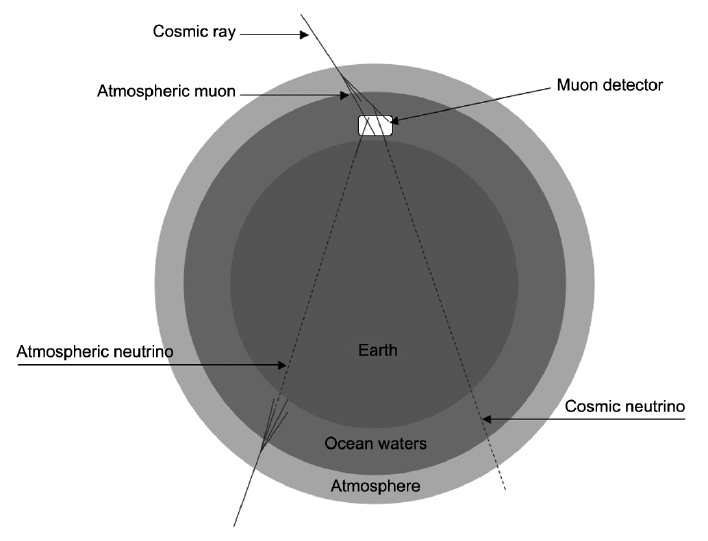
Fig. 2. Detection principle of an underwater neutrino telescope. This instrument will use the whole thickness of the Earth to shield the charged particles cosmic flux and therefore its field of view will be restricted to the hemisphere below the horizon. Nevertheless, a background of atmospheric neutrinos, originated by the interac- tion of charged particle in the atmosphere in the opposte hemisphere, will always be